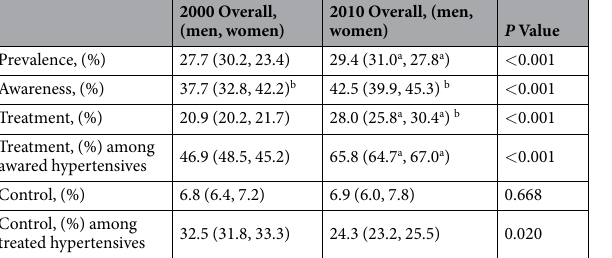
Table 4. Prevalence, awareness, treatment, control of hypertension in 2000 and 2010. Statistical comparisons between 2000 and 2010 are from Pearson chi square tests. a P < 0.05, comparisons between 2000 and 2010 by sex. b P < 0.05, comparisons between men and